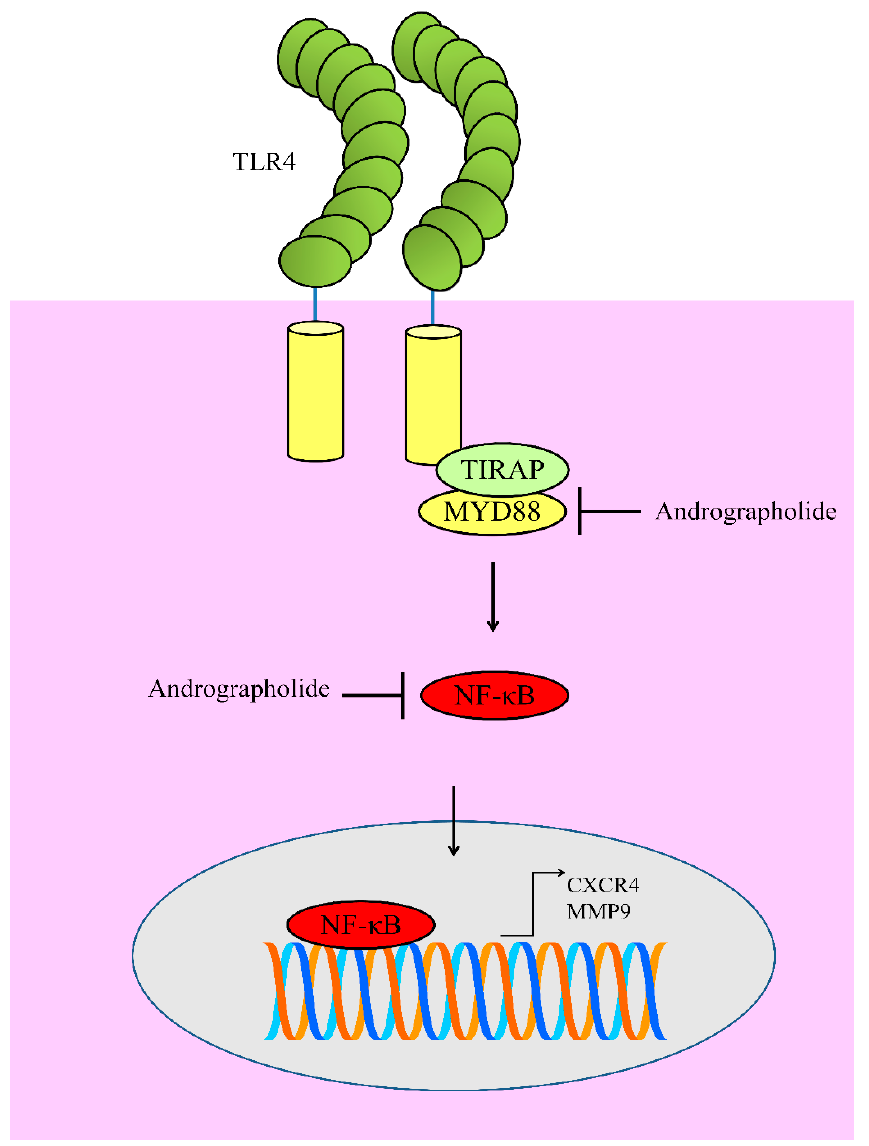
Figure 5. Diagrammatic representation of regulation of TLR4 signaling. Andrographolide inhibited MYD88 mediated activation of NF- κ B. Functionally active NF- κ B moves into the nucleus to regulate expression of target genes. However, andrographolide inhibited NF- κ B activation and prevented its entry into the nucleus.